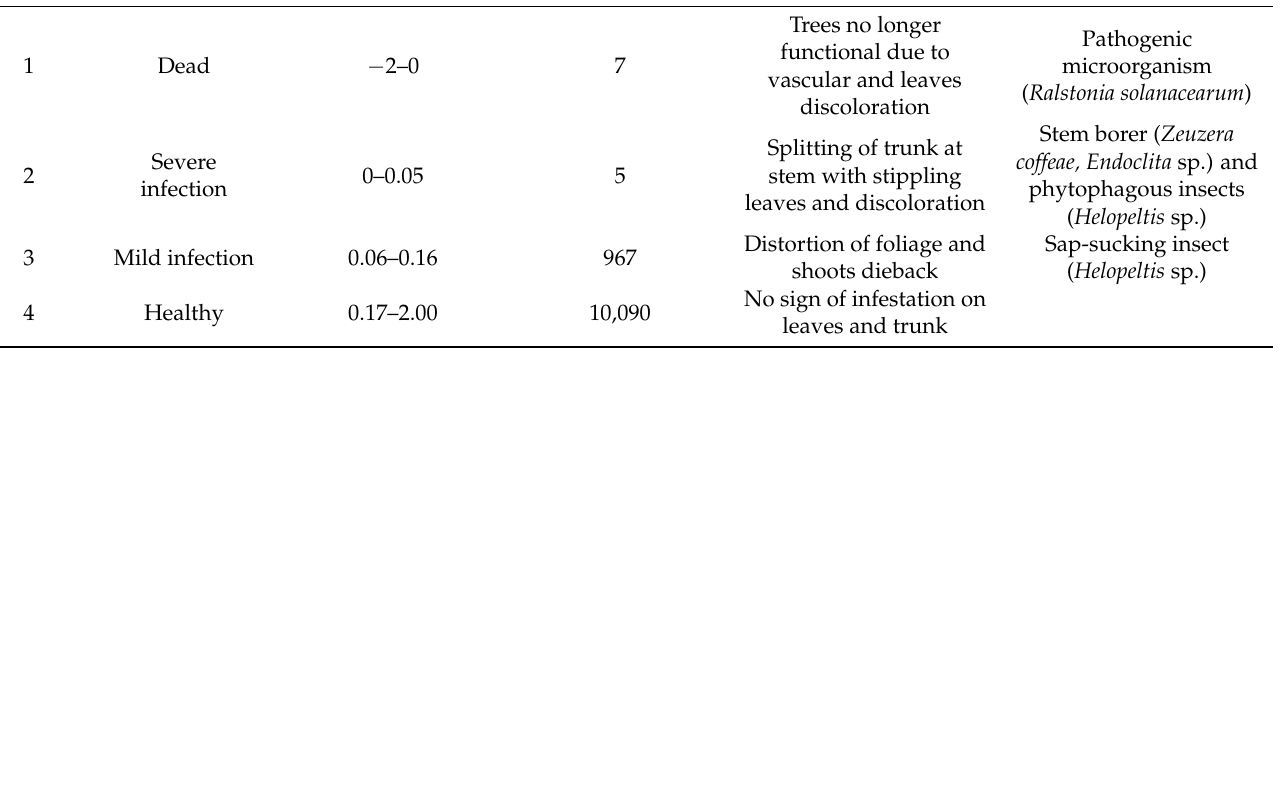
Trees no longer Pathogenic functional due to microorganism vascular and leaves ( Ralstonia solanacearum discoloration